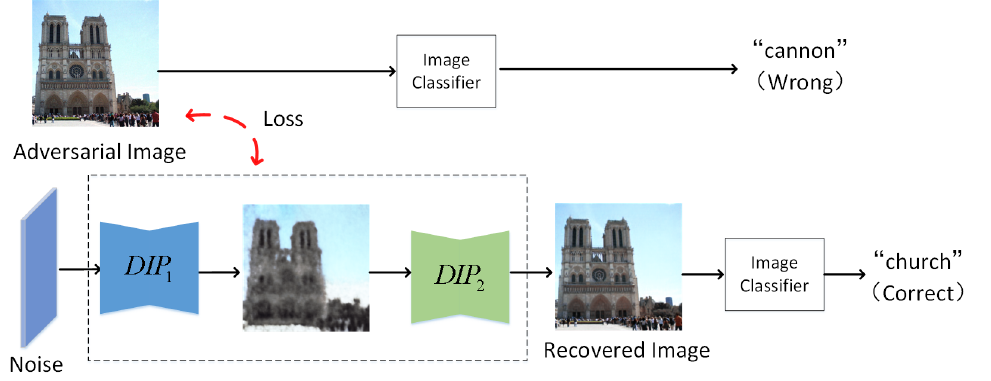
Figure 2. The main idea of t-DIPs. The first network DIP 1 captures the main information of the image. The second network DIP 2 generates the corresponding clean image based on the output of network DIP 1 . The two DIP networks set the loss function as minimizing the difference of recovery image and adversarial